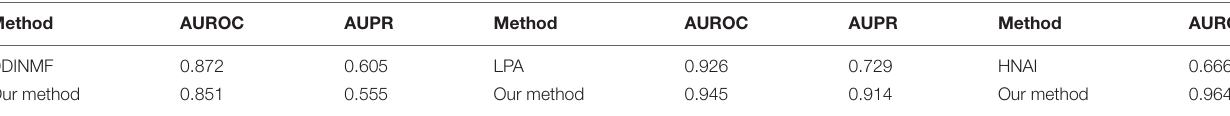
TABLE 3 | Comparison with state-of-the-art methods evaluated by five-fold validation.